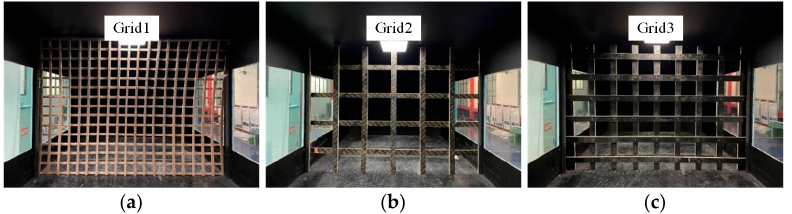
Figure 2. Uniform grids for generating turbulence flows. ( a ) Grid1; ( b ) Grid2; ( c ) Grid3. Table 2. Properties of turbulence flow.